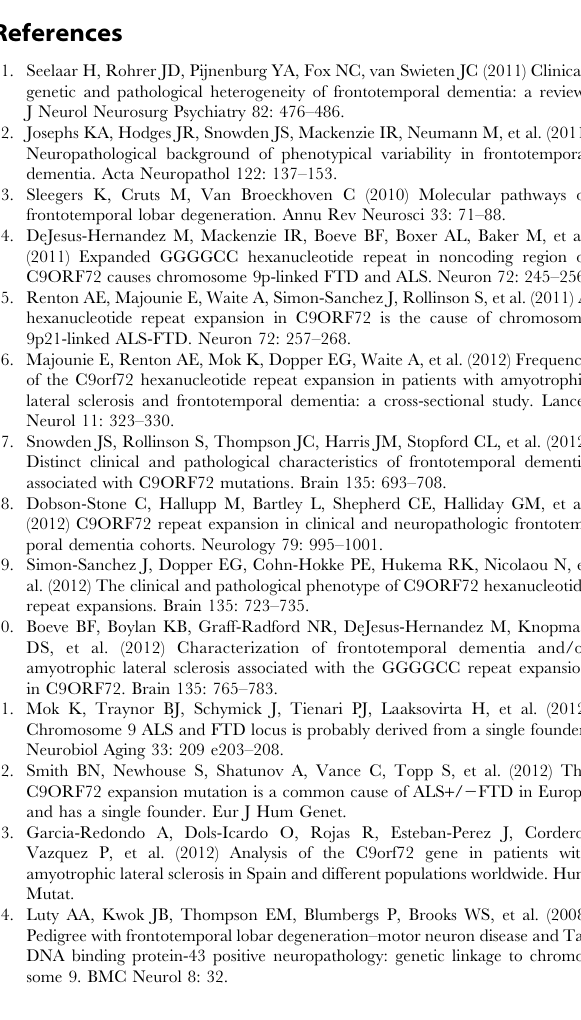
Figure S1 Southern blot analysis of five unrelated probands and three Aus-14 family members with the C9ORF72 repeat expansion, plus an expansion-positive control ( + ). Wild-type (wt) and expansion (exp) alleles are indicated. The smaller expansion 2.9 kb allele in case 100 is arrowed. A band running at , 3.8 kb was also observed (asterisk), probably arising from unspecific probe binding. Table S1 Modified Goldman scale for scoring family